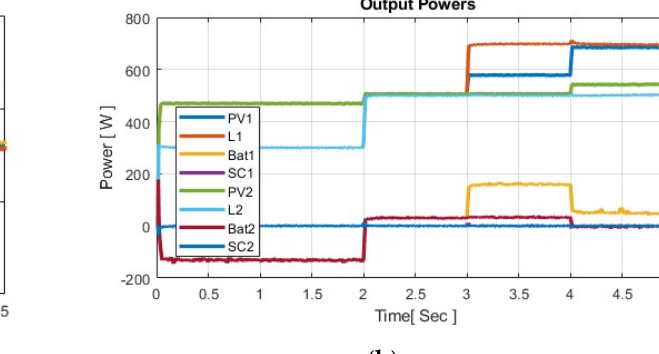
Figure 10. Results using consensus algorithm:( a ) DC voltage; ( b ) output powers: ( c ) battery currents; ( d ) SOCs of batteries; ( e ) SOC of SCs.